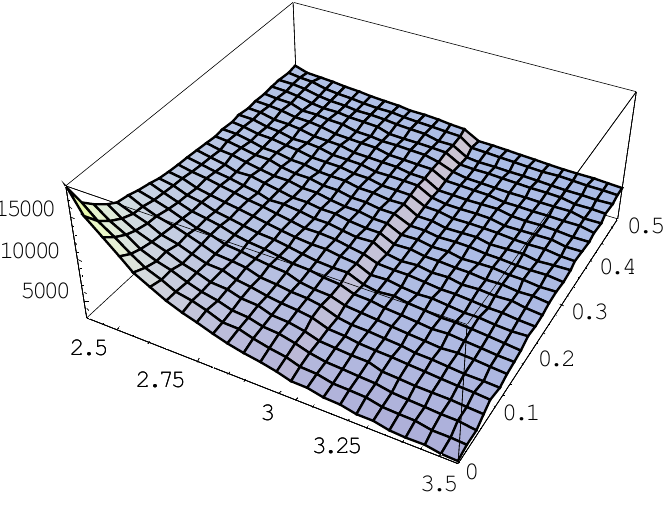
Fig. 6. Total cost per unit time in varies of T